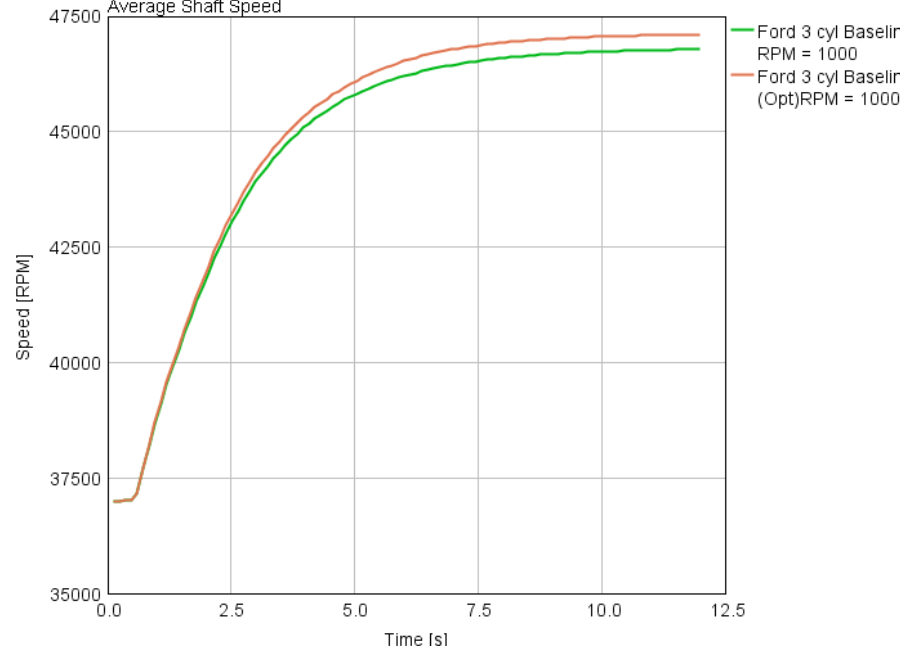
Figure 17. BSFC graphs for the initial and optimized baseline models.